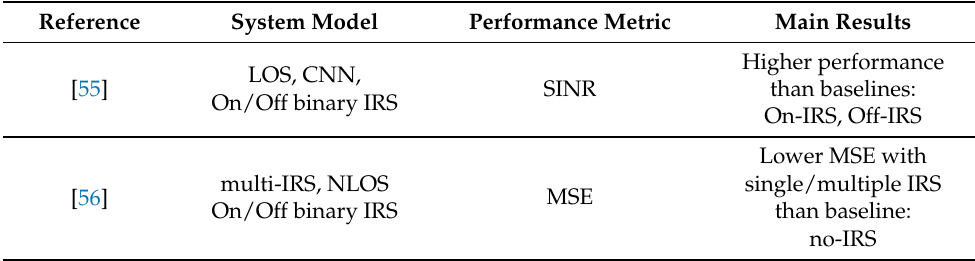
Table 2. Multiuser SISO